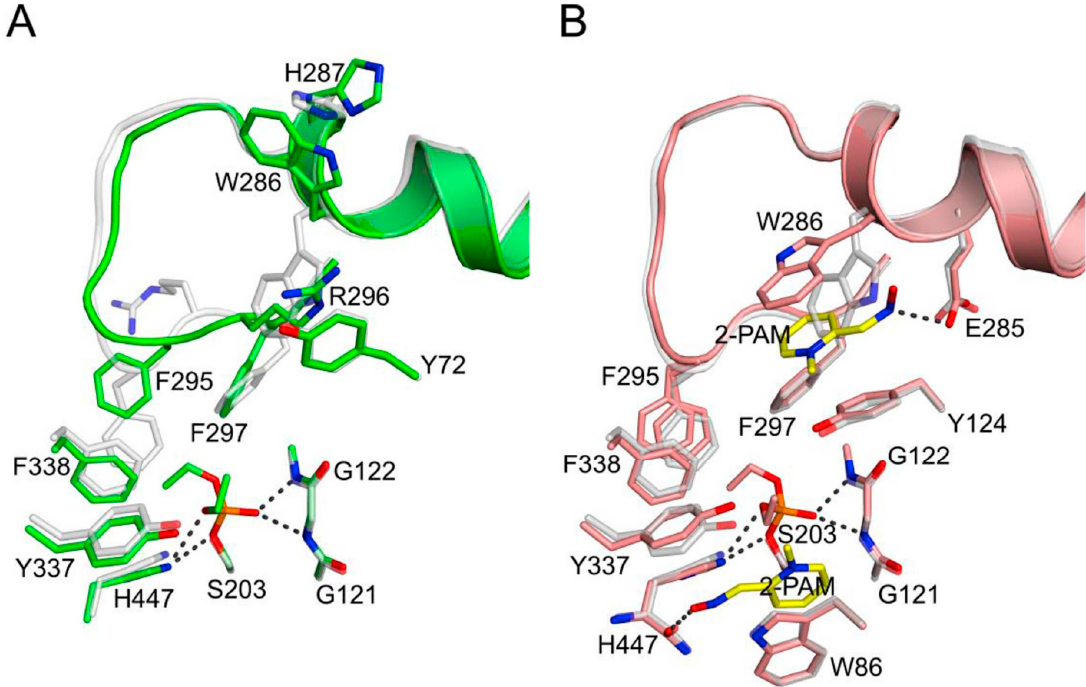
Figure 2. Conformational changes in hAChE induced by paraoxon inhibition [9]. Structural perturbations seen in diethylphosphorylated hAChE without ( A ) and with bound 2 ‐ PAM ( B ) are visualized by superimposition with ligand ‐ free hAChE. Carbon atoms of the oximes are colored yellow, and carbon atoms of protein residues are colored by complex: green in ( A ) and salmon in ( B ); and ligand ‐ free hAChE, semitransparent gray. Nitrogen, oxygen, and phosphorus atoms are colored dark blue, red and orange, respectively. Residues of the helix preceding the acyl loop and of the acyl loop up to position 298 are drawn as ribbons. Atoms of select residues, reactivators and phosphate adducts are drawn as sticks and hydrogen bonds are depicted by dashed gray lines.